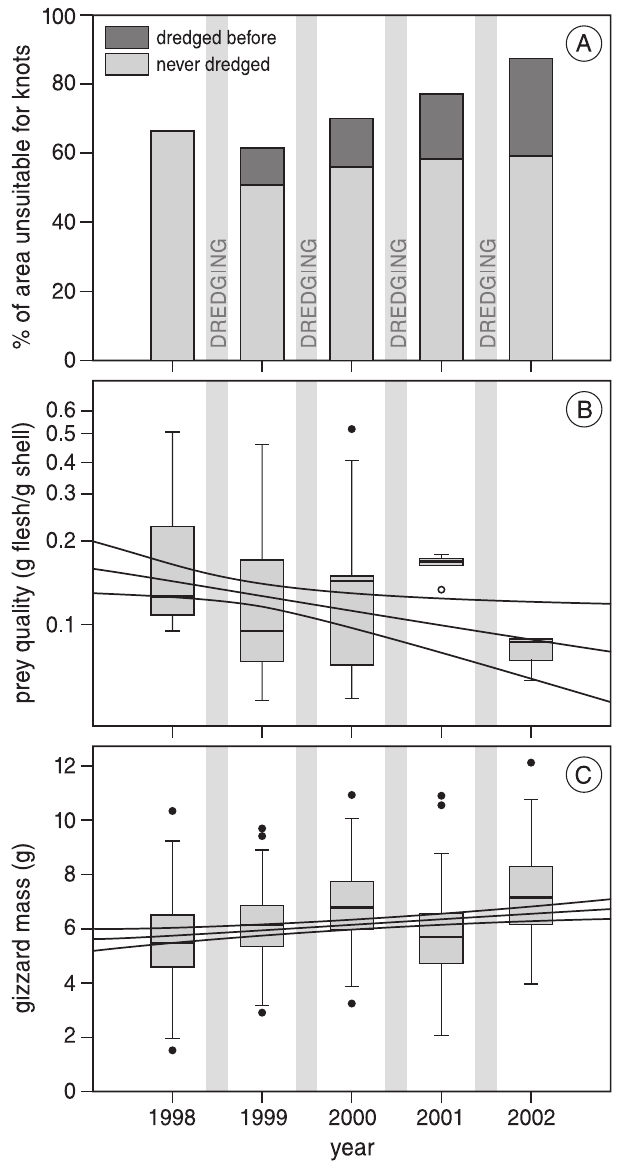
Figure 3. Changes in Suitability, Prey Quality, and Gizzard Mass (A) The percentage of blocks that yielded insufficient intake rates ( , 4.8 W) increased over time due to an increase in unsuitable blocks being dredged in previous years (dark gray bars; as opposed to light gray bars indicating unsuitable blocks that were never dredged). (B) Quality of prey included in the diet has declined over time (box-and- whisker plot, line gives GLM 6 95% confidence intervals). (C) In response, gizzard mass has increased over time (boxes and lines as in (B)). DOI: 10.1371/journal.pbio.0040376.g003